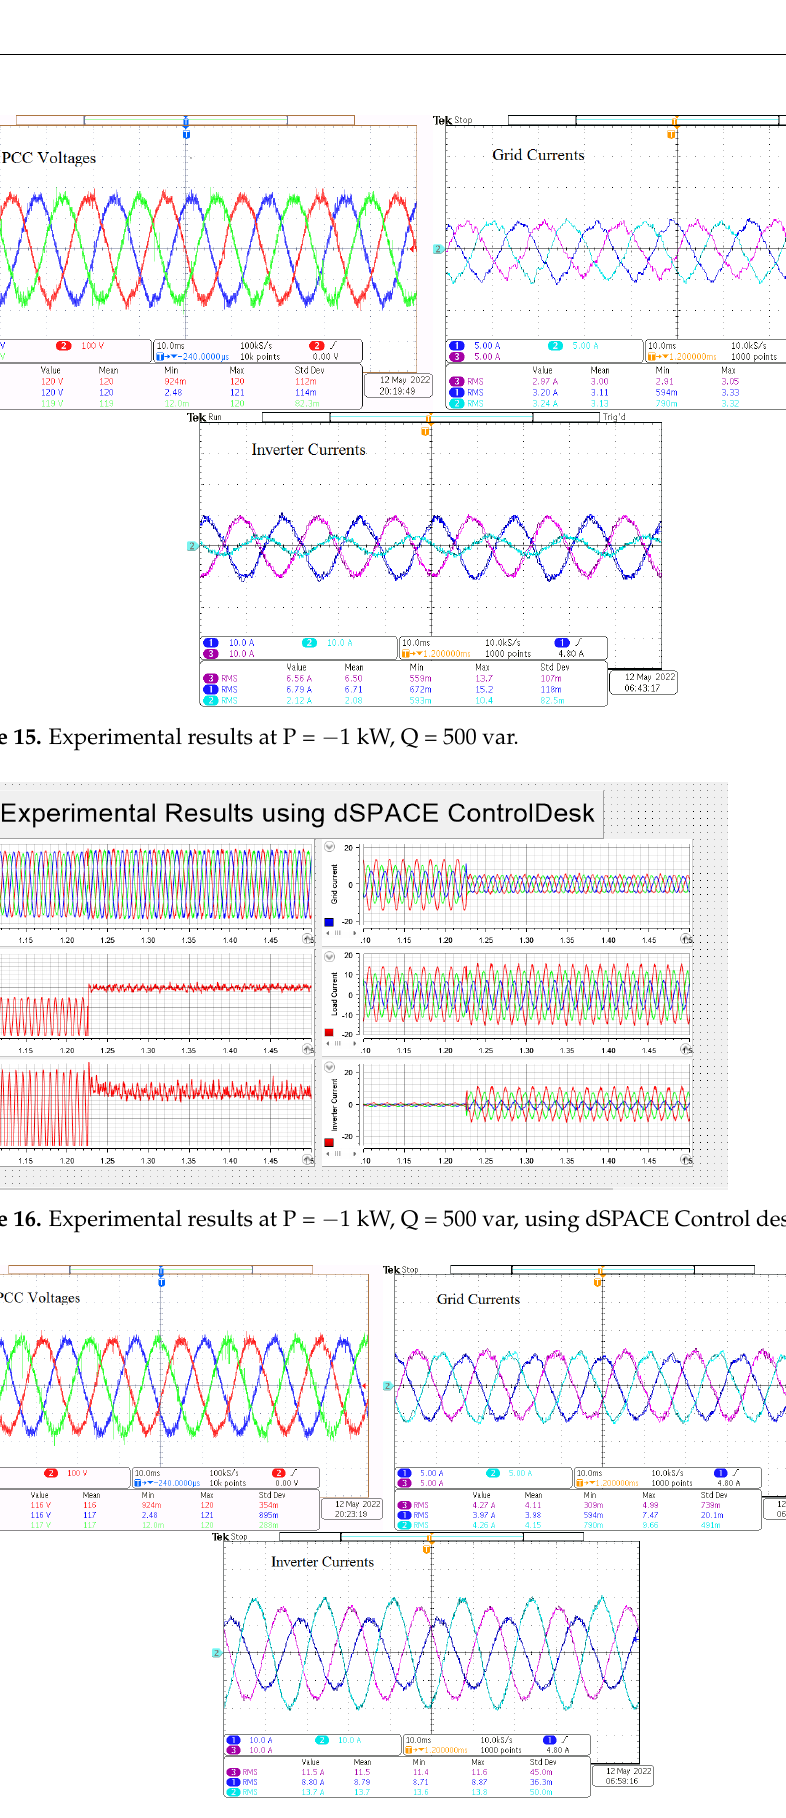
Figure 17. Experimental results at P = 1.5 kW, Q = − 500